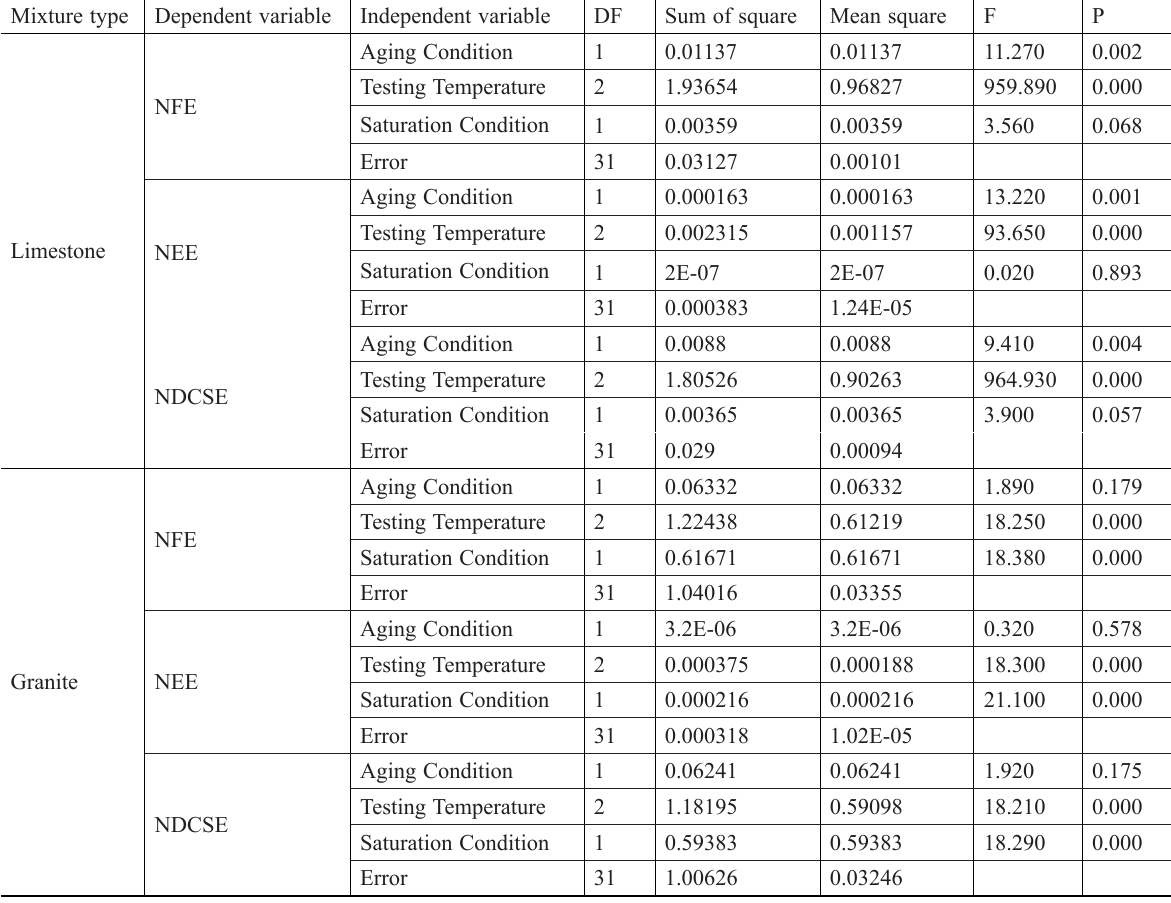
Table 6. Results of ANOVA test on sensitivity of different responses to independent factors Mixture